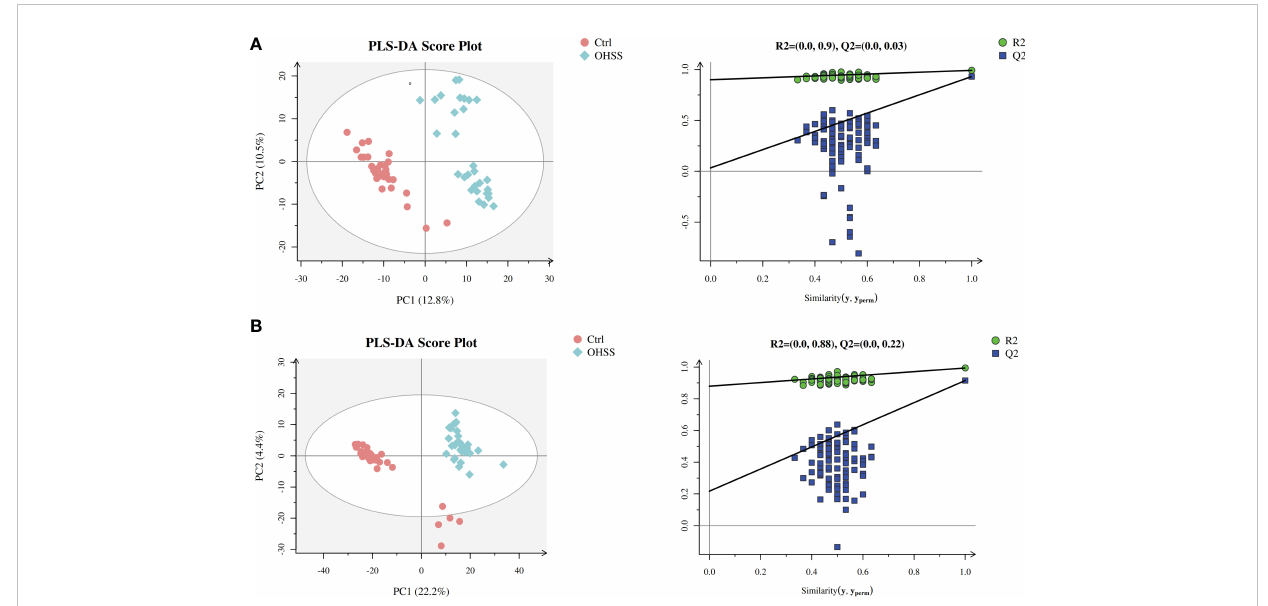
FIGURE 2 PLS-DA score plots of different groups based on follicular fl uid spectral data of ESI ion modes. Follicular fl uid metabolomics pro fi les examined by PLS-DA demonstrated a clear differentiation between the control and OHSS groups. Score plot of the fi rst two principal components (PC1, PC2) from PLS-DA model obtained when comparing the control group and OHSS group: (A) ESI positive mode, model parameters: R2Y=0.992, Q2 = 0.931; (B) ESI negative mode, model parameters: R2Y=0.994, Q2 = 0.915. One point stands for one subject, red circles represent the control, blue diamonds represent